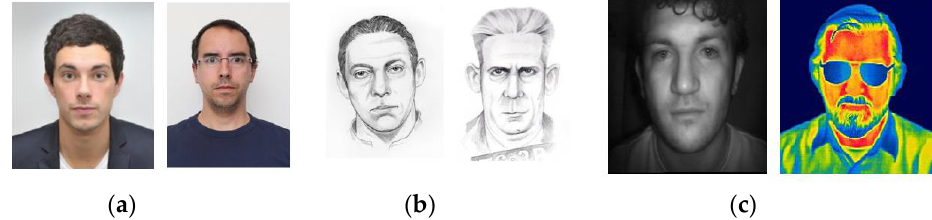
Figure 41. Some modalities of imaging display heterogeneous faces . ( a ) Simple photographs. ( b ) Sketch images. ( c ) Infrared images.